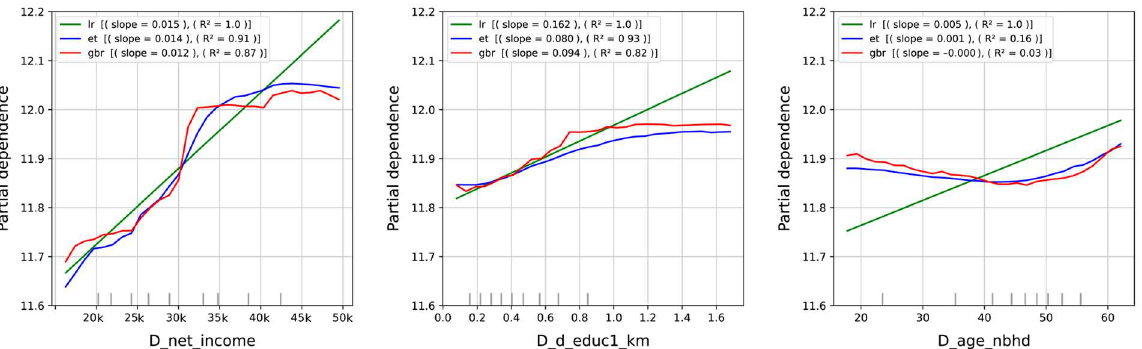
Figure 18. One-way partial dependence plots for net household income, distance to level 1 educa- tional centers, and average age of the neighborhood obtained with the lr , et , and gbr algorithms. The temporal feature is shown in Figure 19, where each graph represents the partial